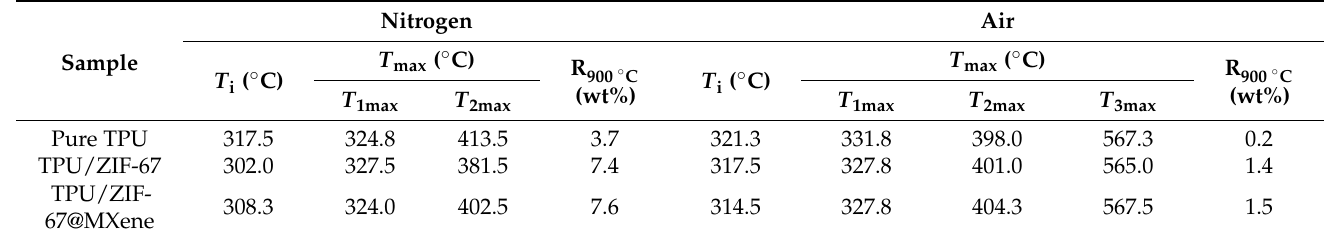
Table 1. Thermogravimetric analysis data of TPU